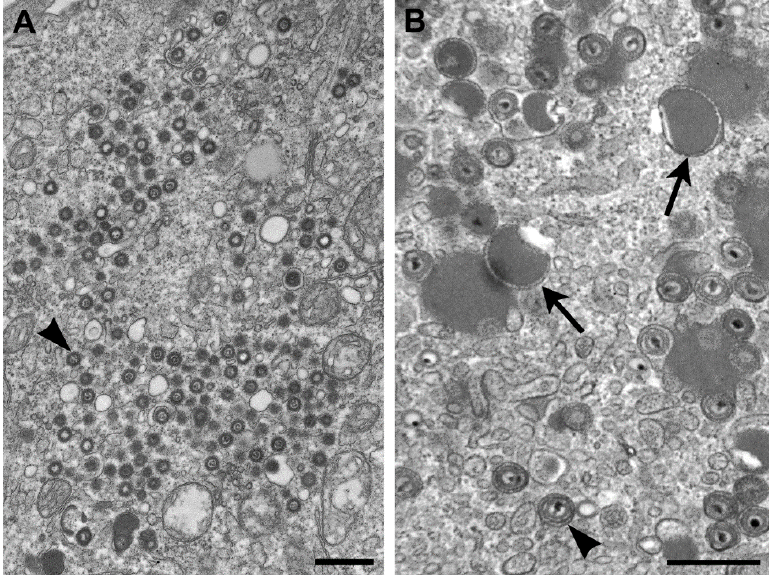
Figure 4. ( A ) Thin section EM image of the cytoplasm of a cell infected with human herpesvirus 7. Note that although there are nucleocapsids surrounded by tegument (arrowhead), there are no dense bodies; ( B ) Cell infected with simian CMV, with dense bodies (arrows) and virus particles (arrowhead) in the cytoplasm. Bars, 500 nm. (Figure